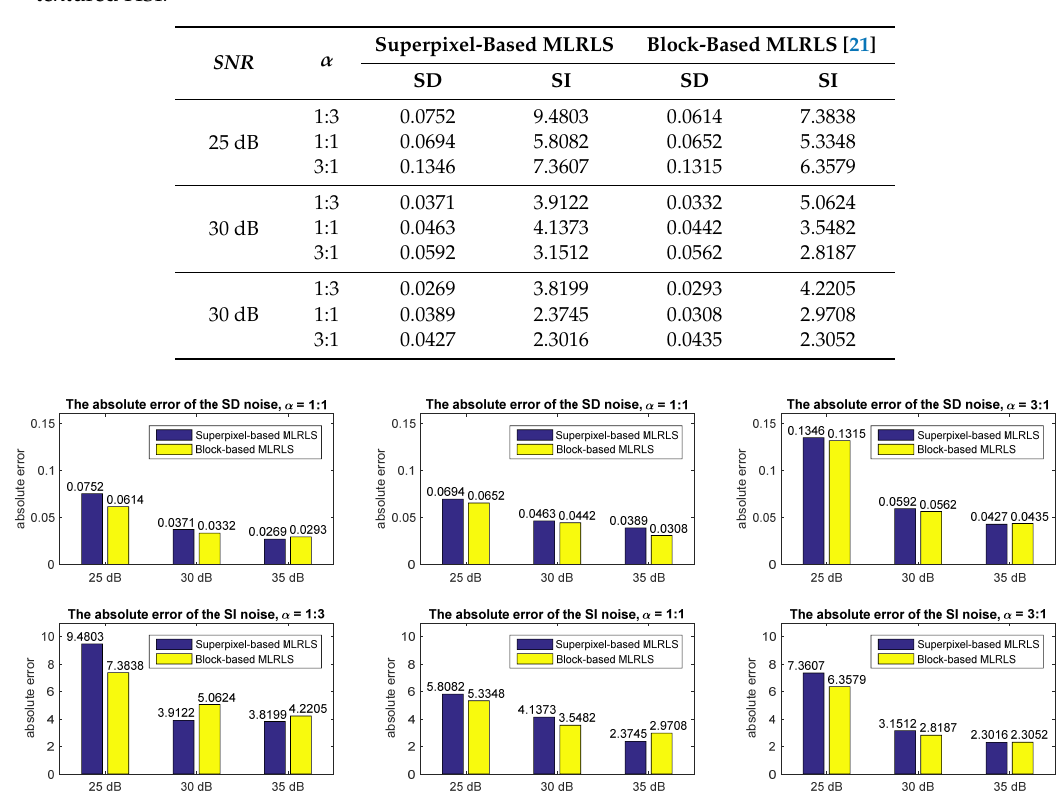
Table 9. The optimal absolute errors of the SD noise, the SI noise and the overall optimization for the textured HSI.